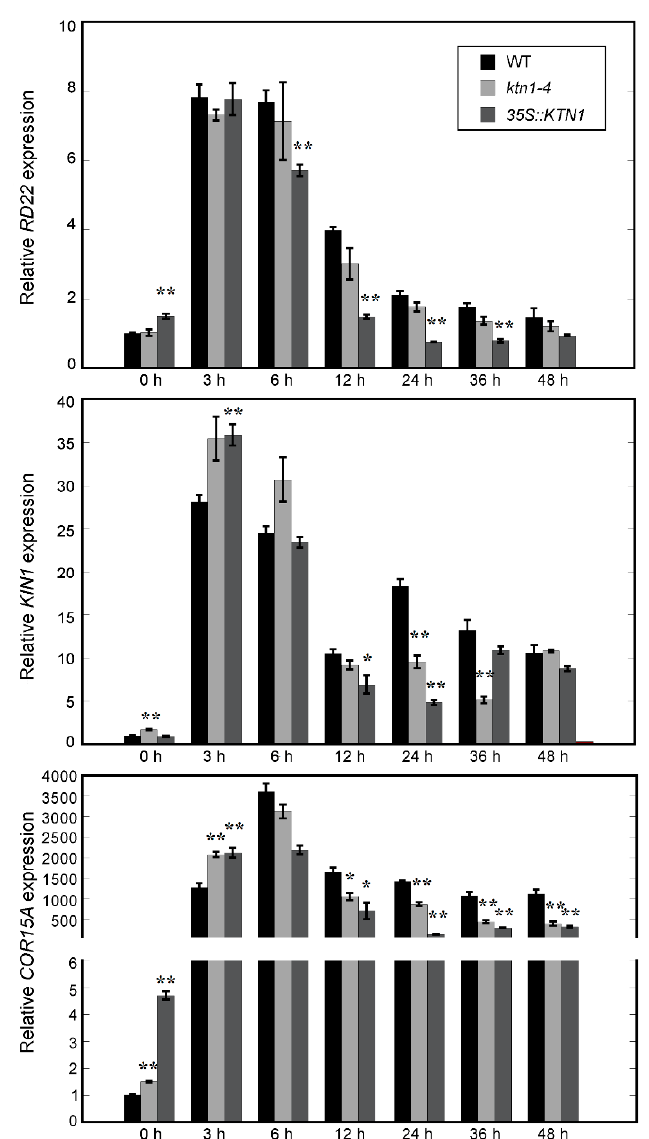
Figure 7. The effects of salt treatment on the transcript levels of stress-responsive genes in Arabidopsis . For salt treatment, four-day-old WT (Col-0), ktn1-4 and 35S::KTN1 seedlings were transferred onto 1/2 MS with 200 mM NaCl for the indicated time period. The transcript levels of every gene in WT (0 h) was normalized as 1.0. Error bars indicate SE. * P < 0.05 and ** P < 0.01 by a Student’s t test.